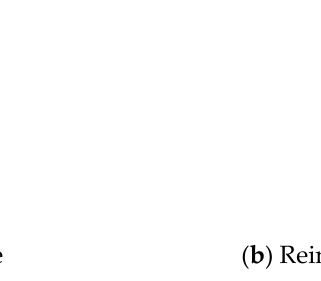
Figure 14. Mesh generation of latticed concrete wall specimen with diagonal bracing. Table 7. Material parameters.